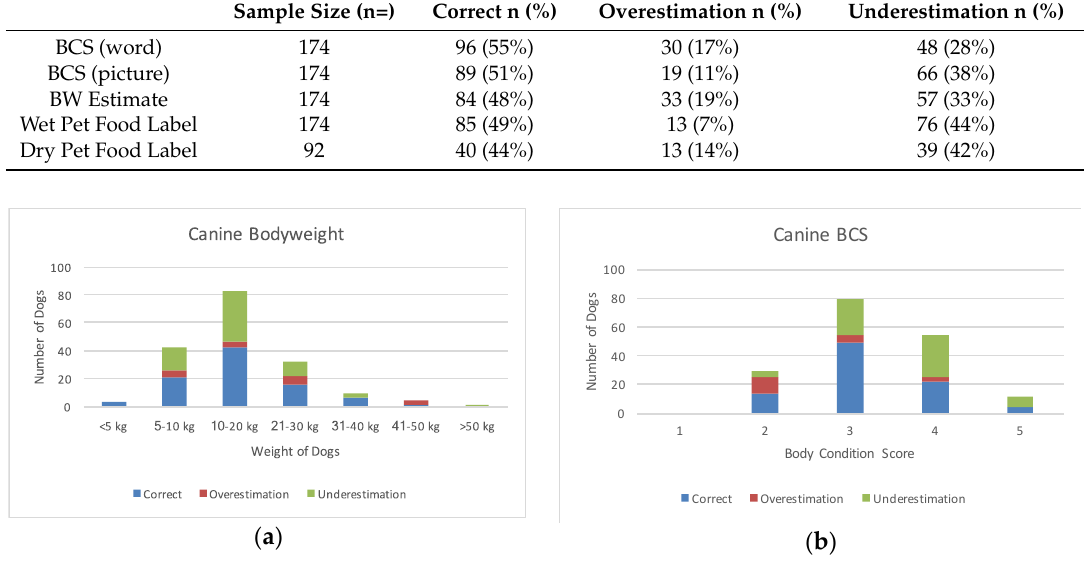
Figure 1. Owner assessment of canine ( a ) bodyweight in kilograms and ( b ) body condition score on a five-point scale. Bars are divided in owner misperception types (correct estimation, overestimation and underestimation).